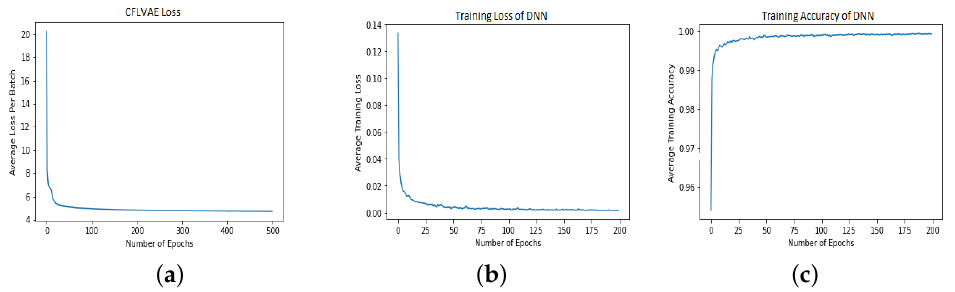
Figure 4. The effects of the training procedure of the CFLVAE and the DNN models. ( a ) CFLVAE loss; ( b ) DNN loss; ( c ) DNN